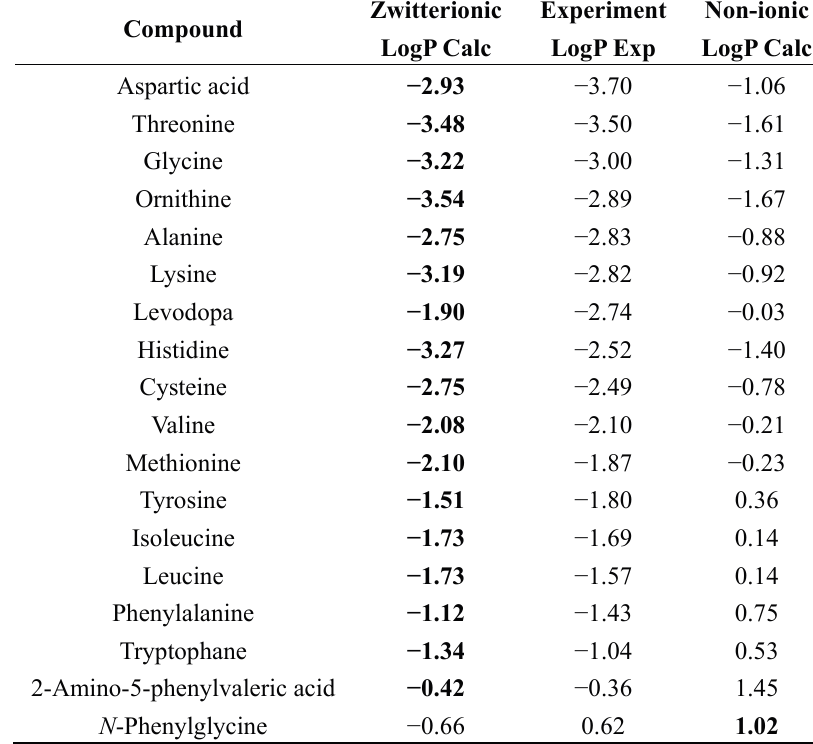
Table 9. LogP of Amino